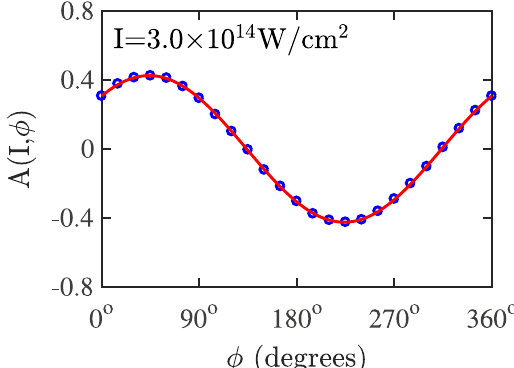
Figure 8. The computed results (blue circles) for the asymmetry parameter A(I, φ ) at I = 3.0 × 10 14 W/cm 2 as a function of φ . The sinusoidal function that is used to fit the computed results is denoted with a red solid line.